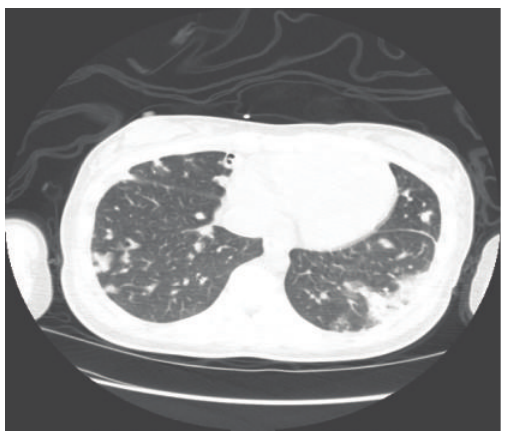
Figure 3: Chest CT scan showing pulmonary nodules.